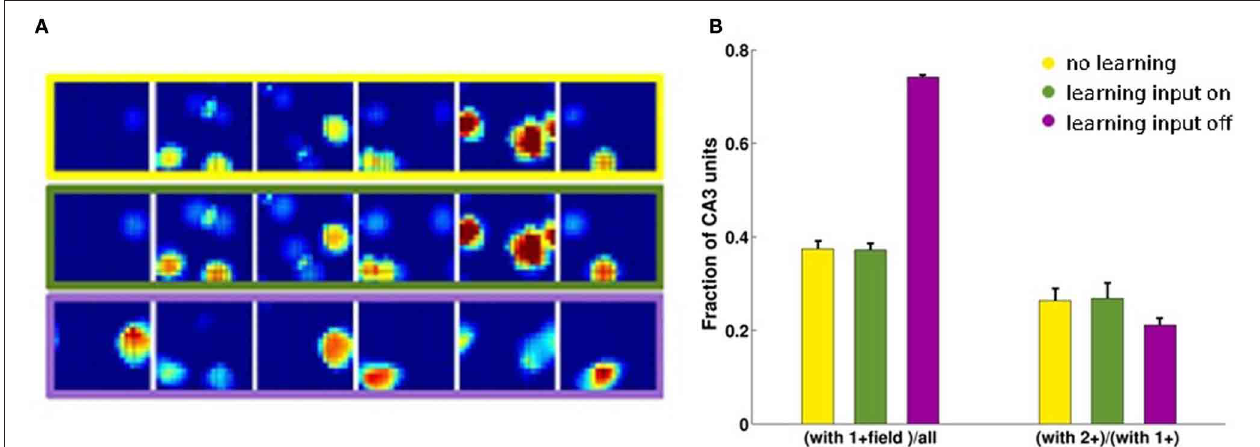
FIGURE 4 | CA3 place fields are refined by learning. Examples of CA3 firing maps in the DG-CA3 model network with MF and RC connections. (A) The top row shows CA3 place fields with no Hebbian learning; the middle row shows the same fields after learning; and the bottom row shows them